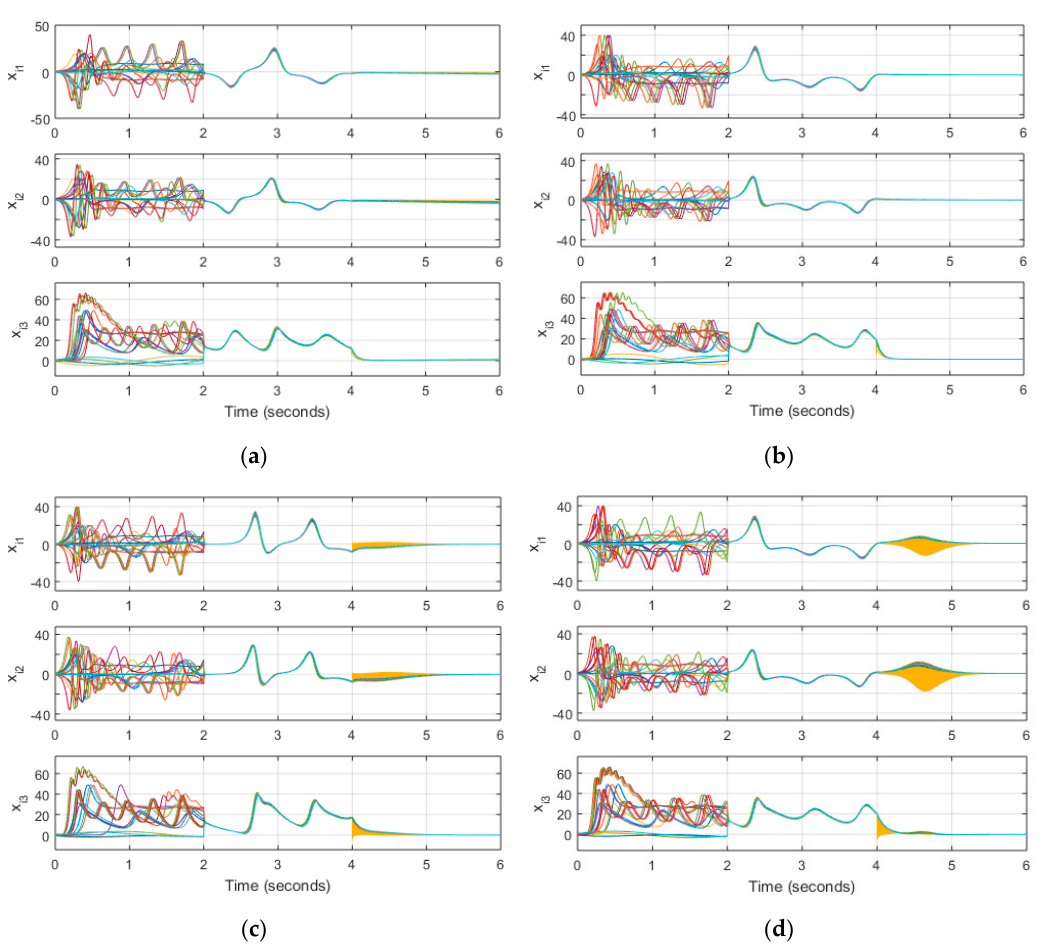
Figure 12. Complex network dynamics for the twenty node network with c = 50, there is only one controlled node, there is noise in the system and: ( a ) Control input is applied at every time step control gain d 3 = 500; ( b ) Control input is applied every time step with control gain d 3 = 800; ( c ) Control input is applied every 5T with control gain d 3 = 1300; ( d ) Control input is applied every 10T with control gain d 3 =